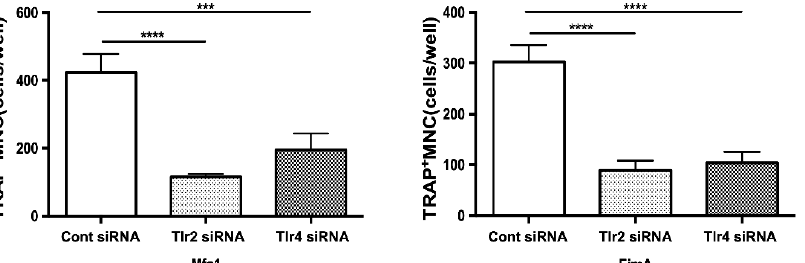
Figure 5. Suppression of TLR2 or TLR4 expression attenuates induction of osteoclastogenesis by Mfa1. Tlr2 siRNA and Tlr4 siRNA-transfected cells prestimulated with 50 ng/mL RANKL for 24 h were stimulated with 1 µ g/mL Mfa1 and FimA fimbriae every 48 h. The number of TRAP-positive multinucleated cells was counted after 96 h. Differences between groups were analyzed by ANOVA and Tukey’s test. Data are expressed as the mean ± SD ( n = 4). *** p < 0.001, **** p < 0.0001.